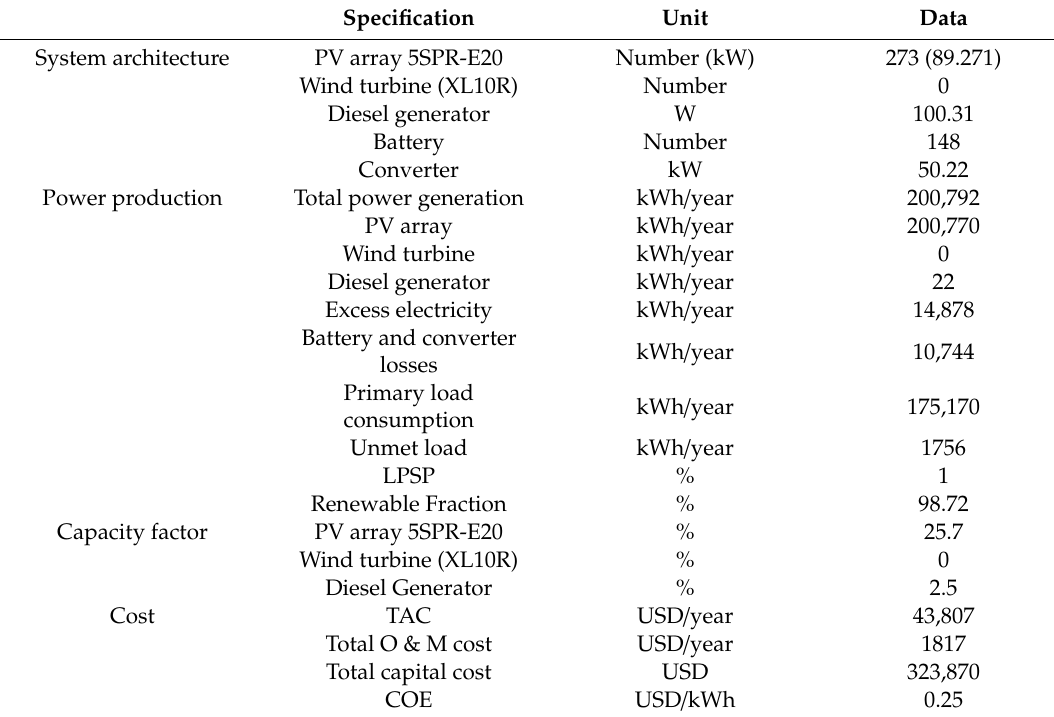
Table 7. Technical and economic specifications of the optimal